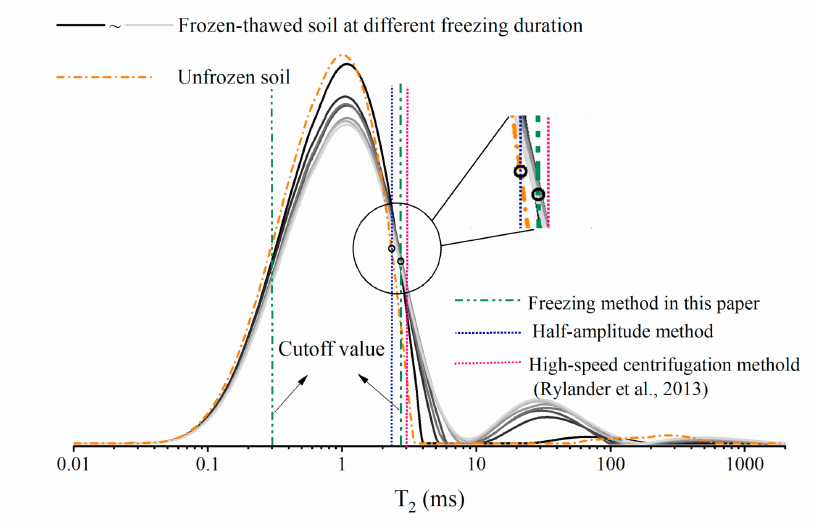
Figure 18. Cutoff values tested by three